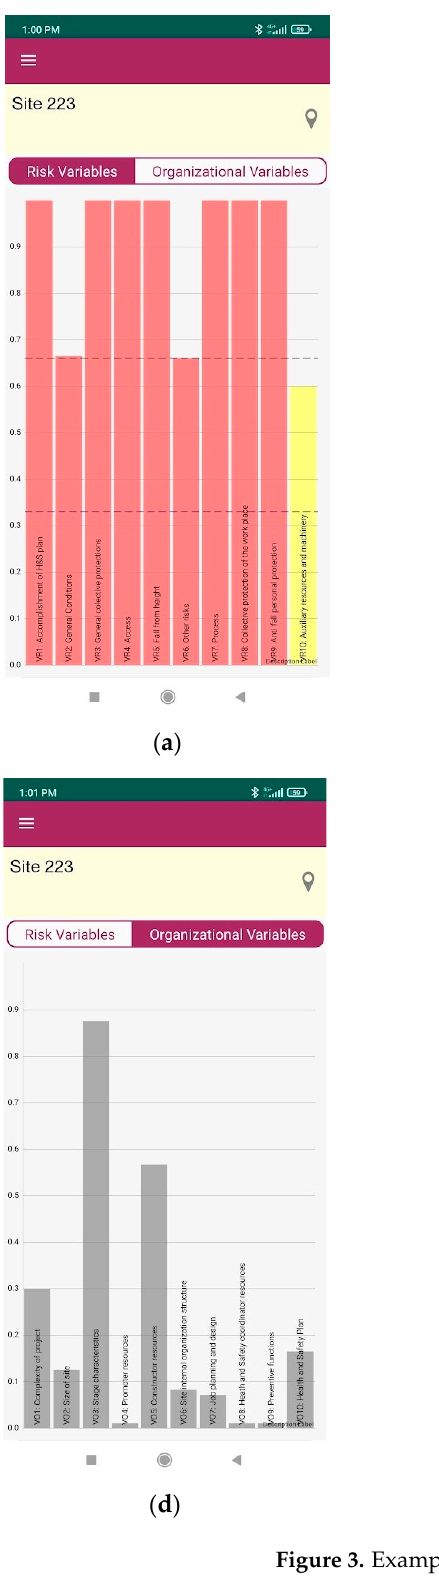
Figure 2. Pictures of the three different sites classified by their level of risk. From left to right: high (code 223), low (code 938), and medium (code 302). Source: from the authors’ archive.